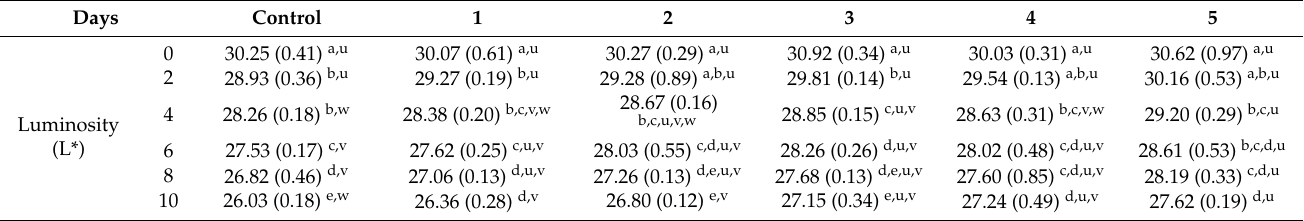
Figure 6. Images of ( A ) tomatoes treated with different keratin/gel/gly/cur composite films before and after storage for 10 days, ( a ): not film wrapped, ( b – f ) the concentrations of curcumin: 0.4, 0.6, 0.8, 1.0, and 1.2%, ( B , C ) The effects of different concentrations of curcumin on weight-loss rate and hardness before and after 10 days, and ( D ) the antibacterial property of different concentrations of curcumin for keratin/gel/gly/cur composite films on two pathogens ( Staphylococcus aureus and Escherichia coli ), ( a’ ): no film placed, ( b’ – f’ ) the concentrations of curcumin: 0.4, 0.6, 0.8, 1.0, and 1.2%. Table 1. Effects of different concentration of curcumin on color attributes of cherry tomatoes stored at room temperature for 10 days.